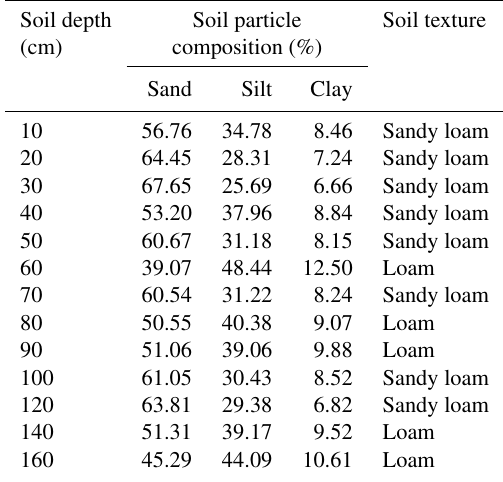
Table 1. Distribution of soil particle composition according to the USDA soil texture classification